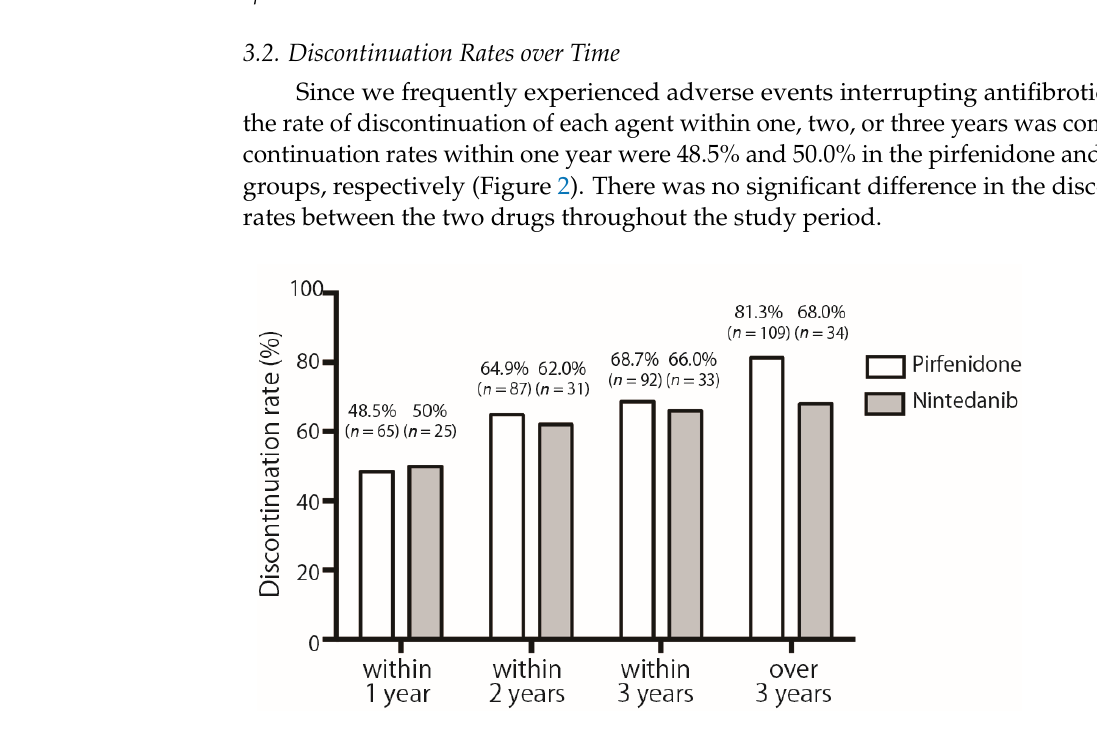
Figure 2. Discontinuation rate of pirfenidone and nintedanib over time.